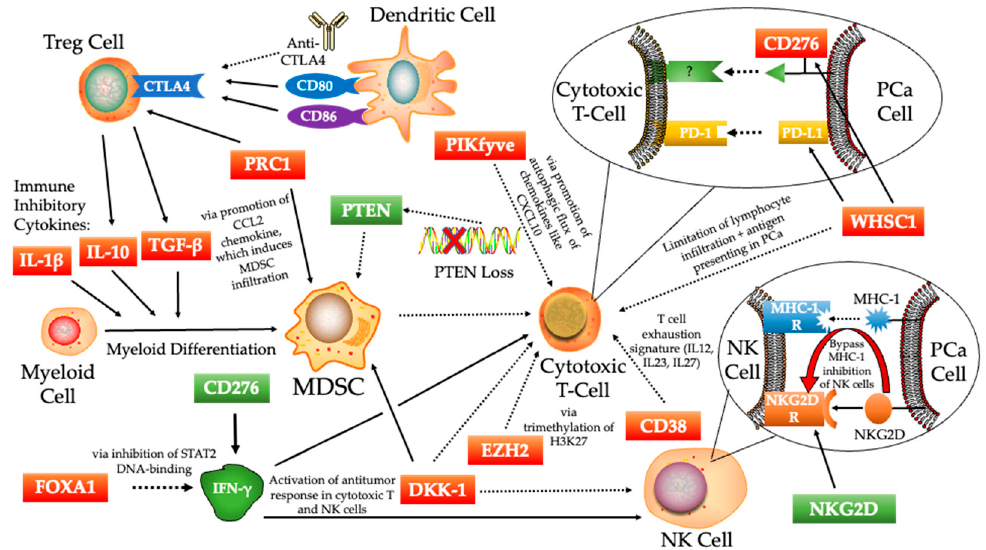
Figure 2. Specific mechanisms for different molecules in the tumor immune microenvironment (TIME) of prostate cancer. These are novel targets of interest which have been highlighted through publications in recent years. Solid arrows represent upregulation of that cell’s expression or a specific function at the end of the arrow. Dashed arrows indicate inhibition of the cell or function at the end of the arrow. The color of the boxed molecules represents whether they are immunosuppressive (red) or an immune enhancer (green). Note that CD276 had co-stimulatory and inhibitory roles in the immune response. T-reg, regulatory T; MDSC, myeloid-derived suppressor cell; NK, natural killer; IFN- γ , interferon-gamma; PCa, prostate cancer.